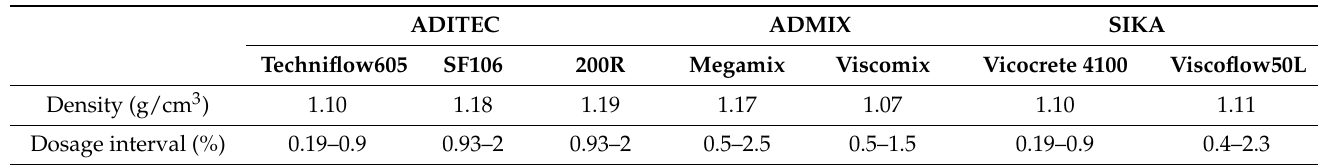
Table 2. Chemical additives supplied by three different manufacturers.